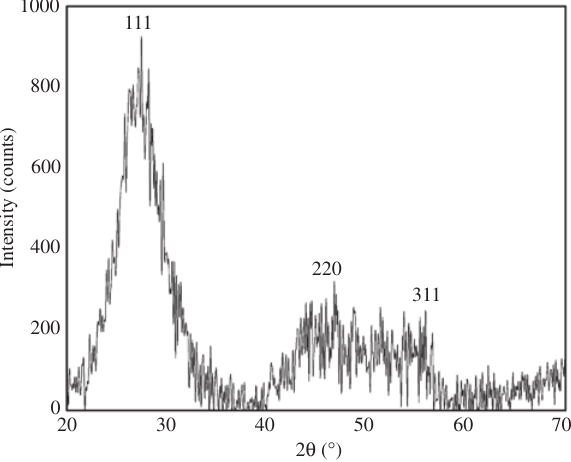
Figure 8: Powder X-ray diffraction (XRD) pattern of zinc sulfide nan- oparticles synthesized using the cell free extract of Chlamydomonas reinhardtii